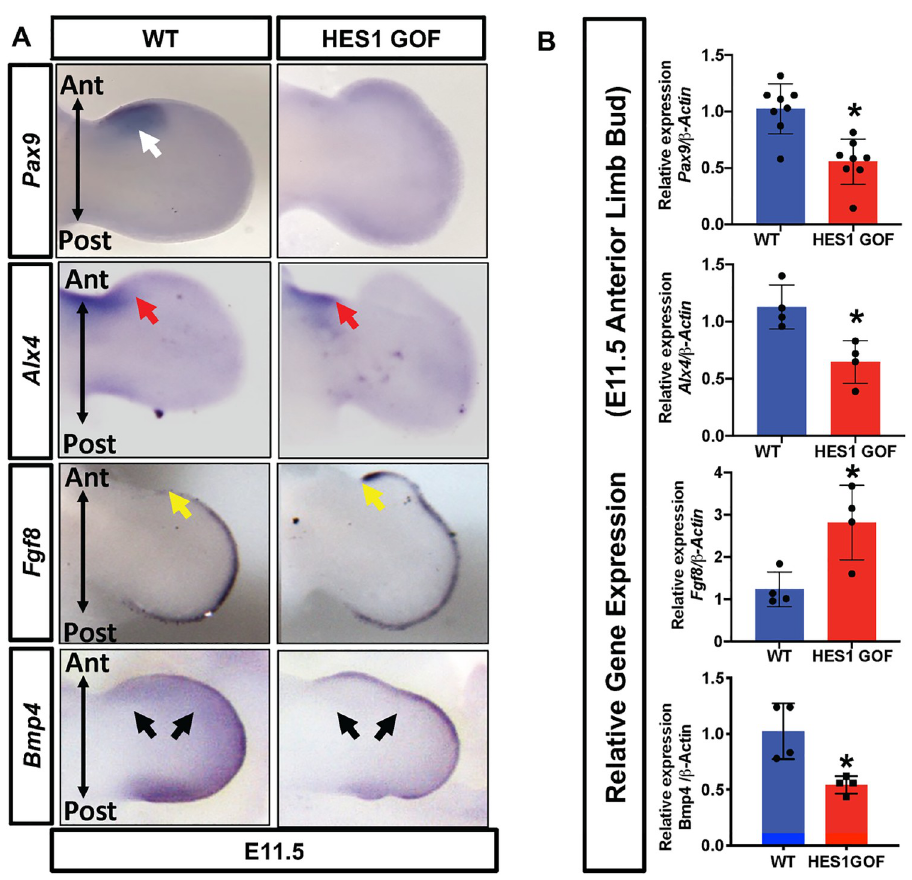
Fig 4. Hes1 over-expression within limb bud mesenchyme alters the expression of digit patterning factors. (A) WISH for Pax9 , Alx4 , Fgf8 and Bmp4 on E11.5 WT and HES1 GOF limb buds. (B) qPCR performed on RNA from E11.5 WT and HES1 GOF limb buds (N � 4). Each data point represents separate animals. Asterisks indicate significance with a p-value < 0.05 (Student’s t-test).